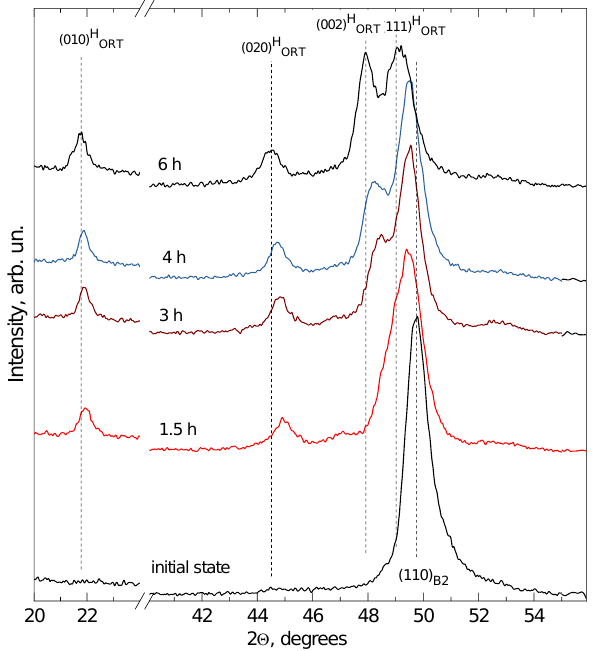
Figure 6. X-ray diffraction patterns of Ti 49.4 Ni 50.6 (at%) before and after hydrogenation at 295 K in normal saline for 1.5, 3, 4, and 6 h (20 A/m 2 ). (This figure is in color only in the electronic version.)